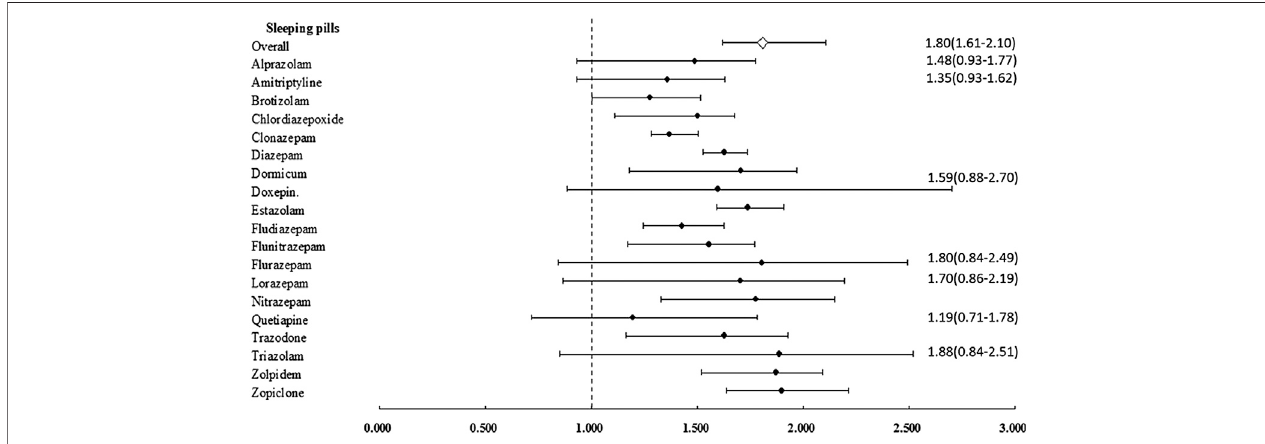
FIGURE 2 | Adjusted hazard ratio of chronic kidney disease (CKD) in individuals with affected sleeping pills. Error bars indicate 95% con fi dence interval